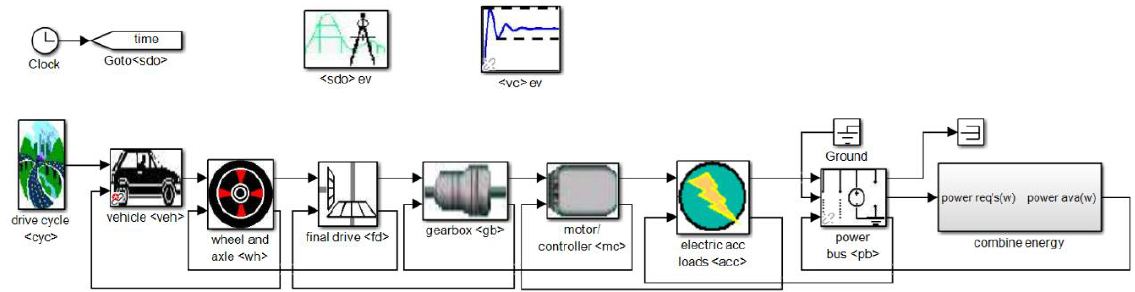
Figure 8. Vehicle model of